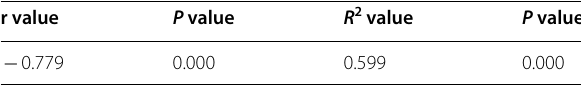
Bold Statistically significant = Table 9 Correlation between ADC and Ki67